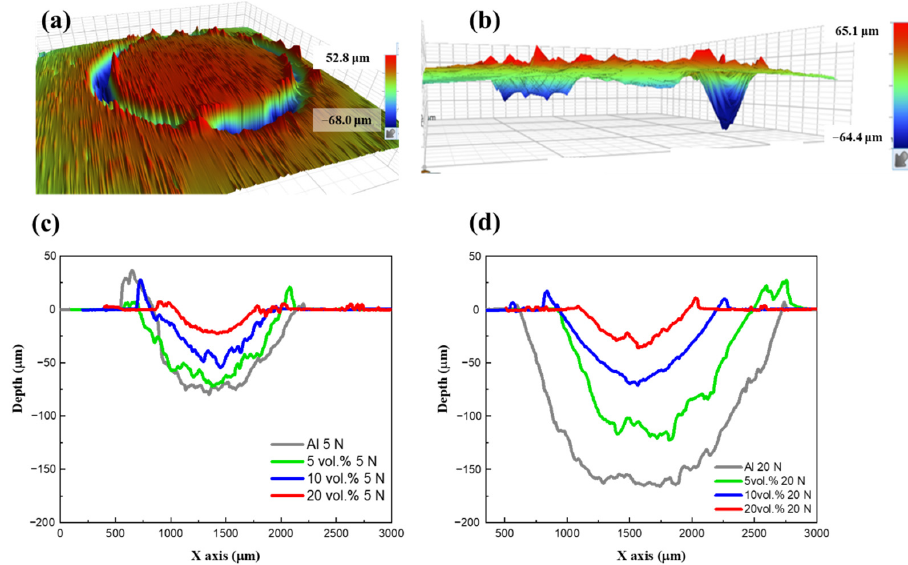
Figure 6. ( a , b ) 3D wear surface images of 10 vol.% B 4 C/Al6061 composites tested at 20 N load measured using an alpha step. The wear width and maximum wear depth of Al6061 and B 4 C/Al6061 composites were tested at ( c ) 5 N and ( d ) 20 N loads.